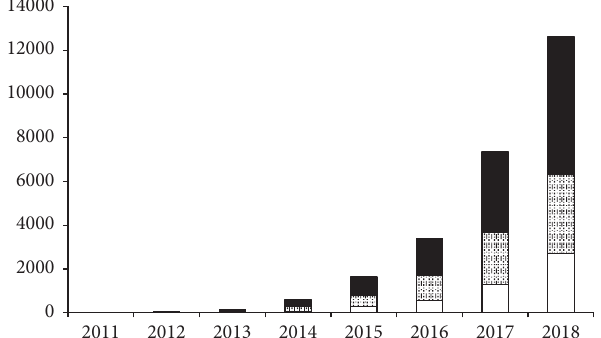
Figure 2: Number of CR Express trains counted from 2011 to 2018 (unit: shift). The black bar means the total volume of one proper year, the white bar refers to the going back trains, and the other one represents the going forth